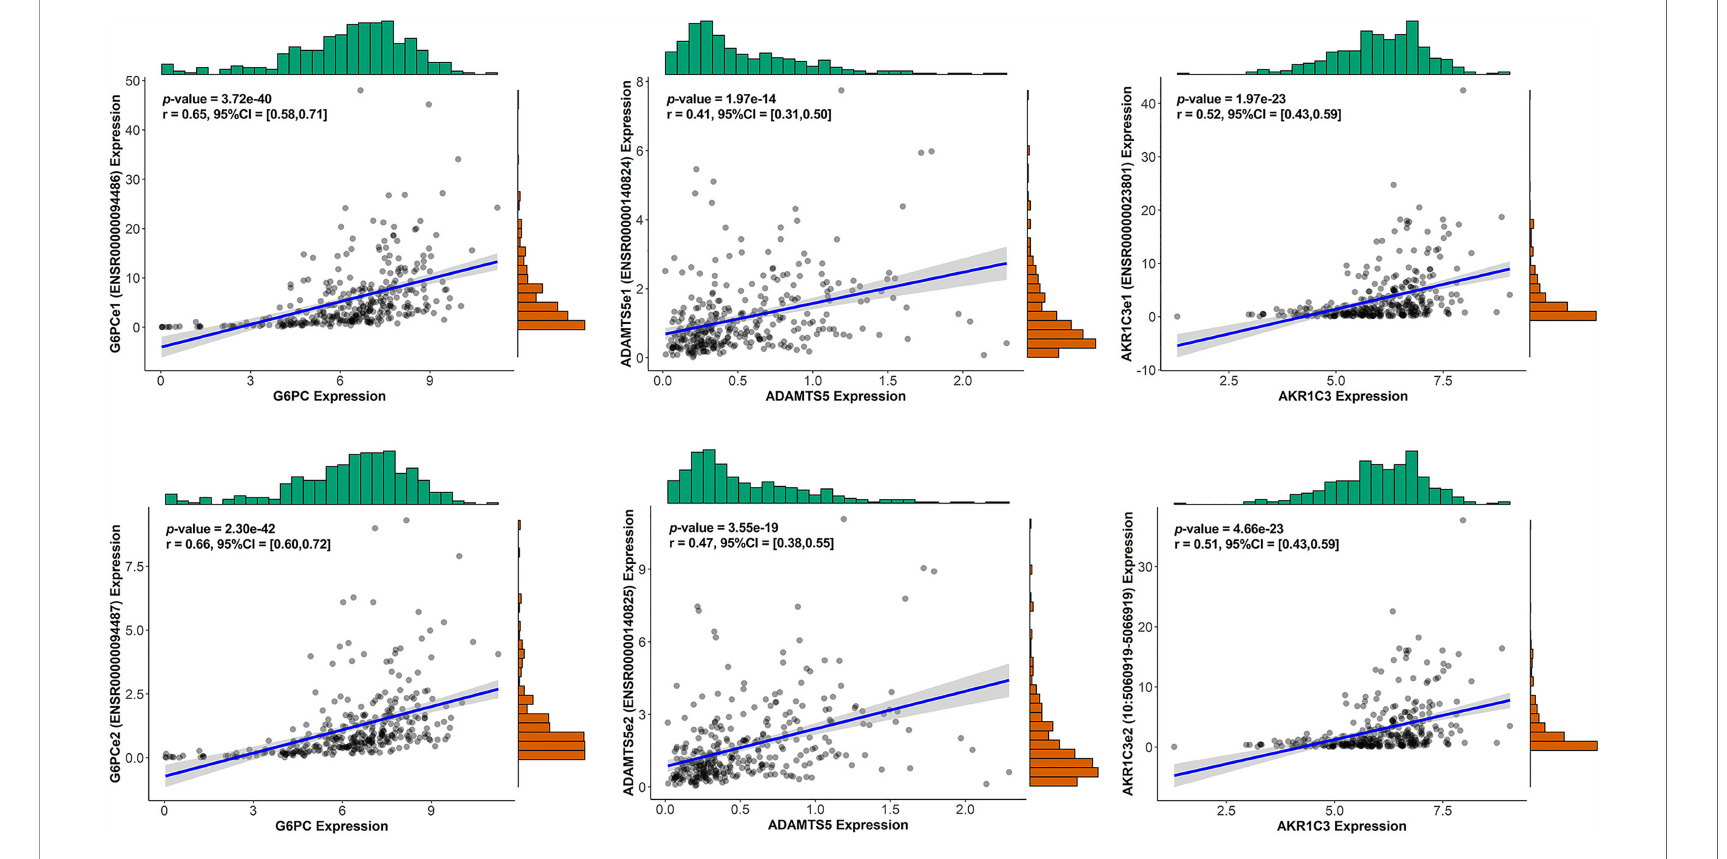
FIGURE 2 | The correlation between genes in the signature and their corresponding eRNA (part